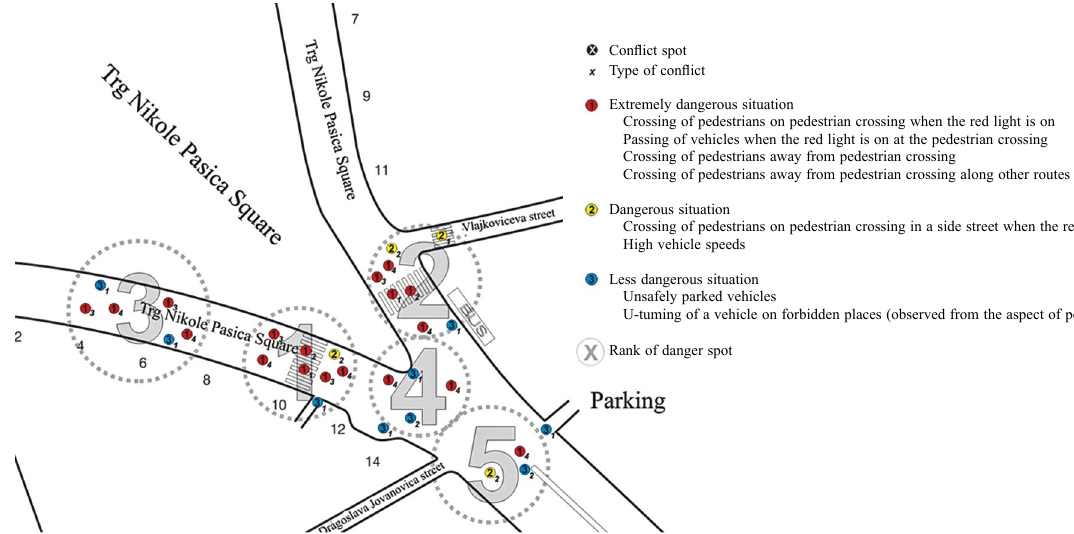
Fig. 5. The spatial distribution of conflicts (Vujanić et al. 2009b)